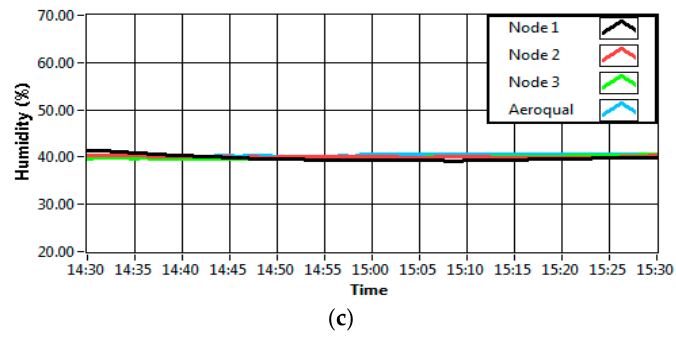
( c ) Figure 2. ( a ) NO 2 data; ( b ) Temperature data; ( c ) Humidity data. Figure 2. ( a ) NO 2 data; ( b ) Temperature data; ( c ) Humidity data.